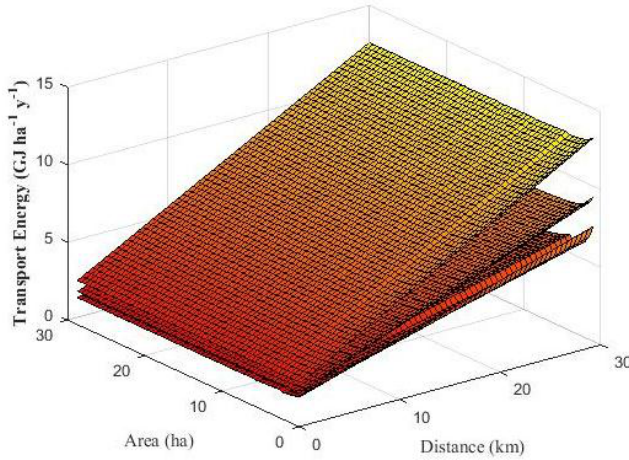
Figure 11. The biomass transport energy requirements for three sizes of wagons, higher surface: 10 m 3 capacity; middle surface: 20 m 3 capacity; lower surface: 40 m 3 capacity.